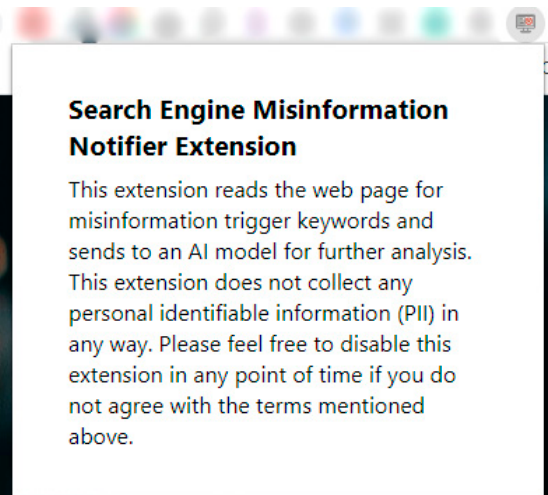
Figure 2. Privacy notice.